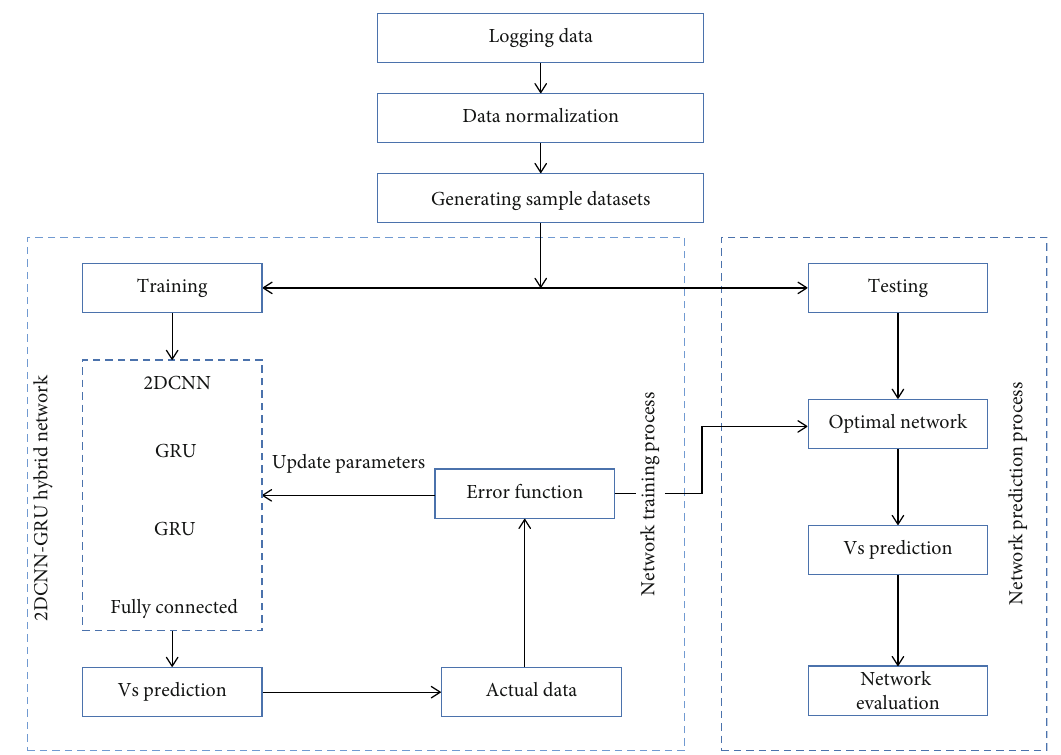
Figure 4: The VS prediction framework of the 2DCNN-GRU hybrid